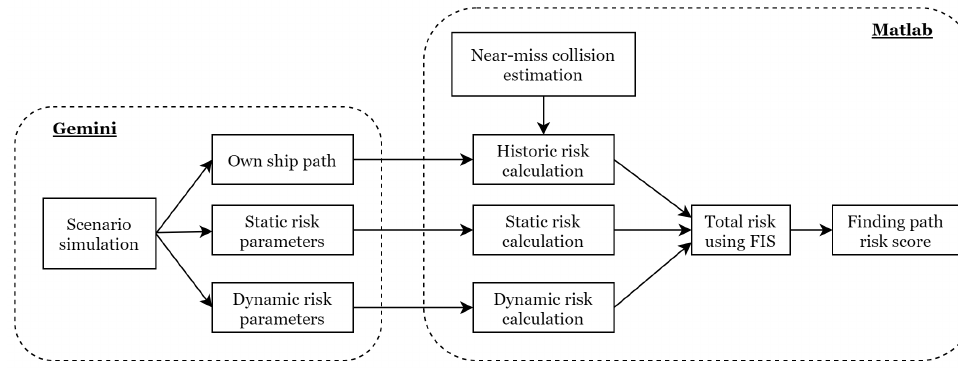
Figure 6. Architecture of the simulation framework used for ECRA